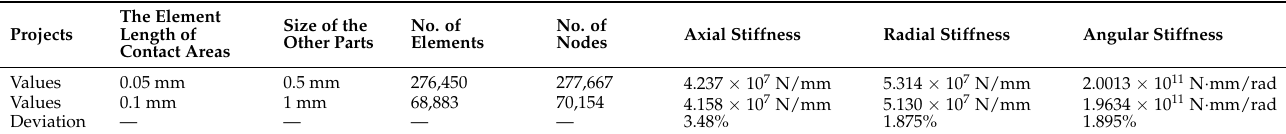
Table 1. Stiffness of interface under different mesh